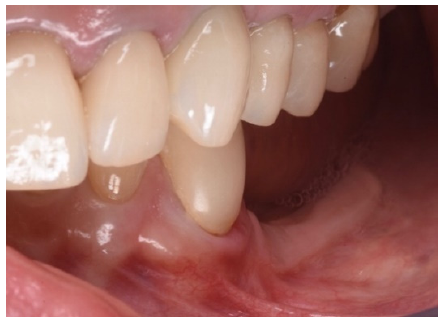
Figure 5. Soft tissue healing at three